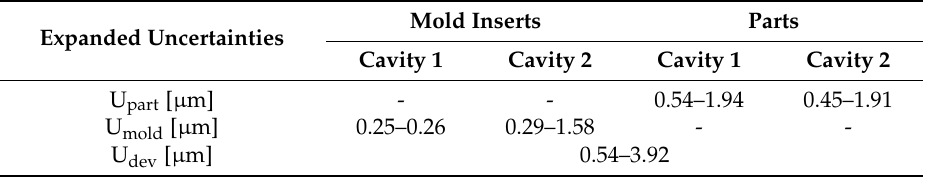
Table 4. Expanded uncertainty for single pillar height and height deviations measurements.